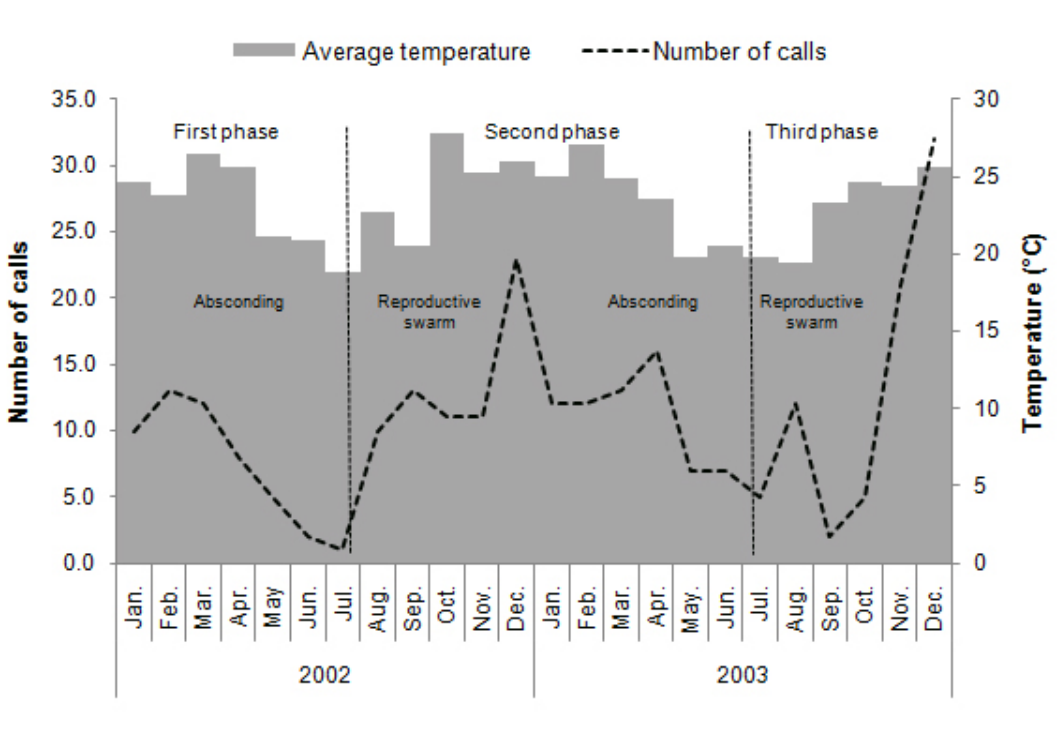
Figure 2. Number of calls to the Rio Claro fire brigade and average temperature during 2002 and